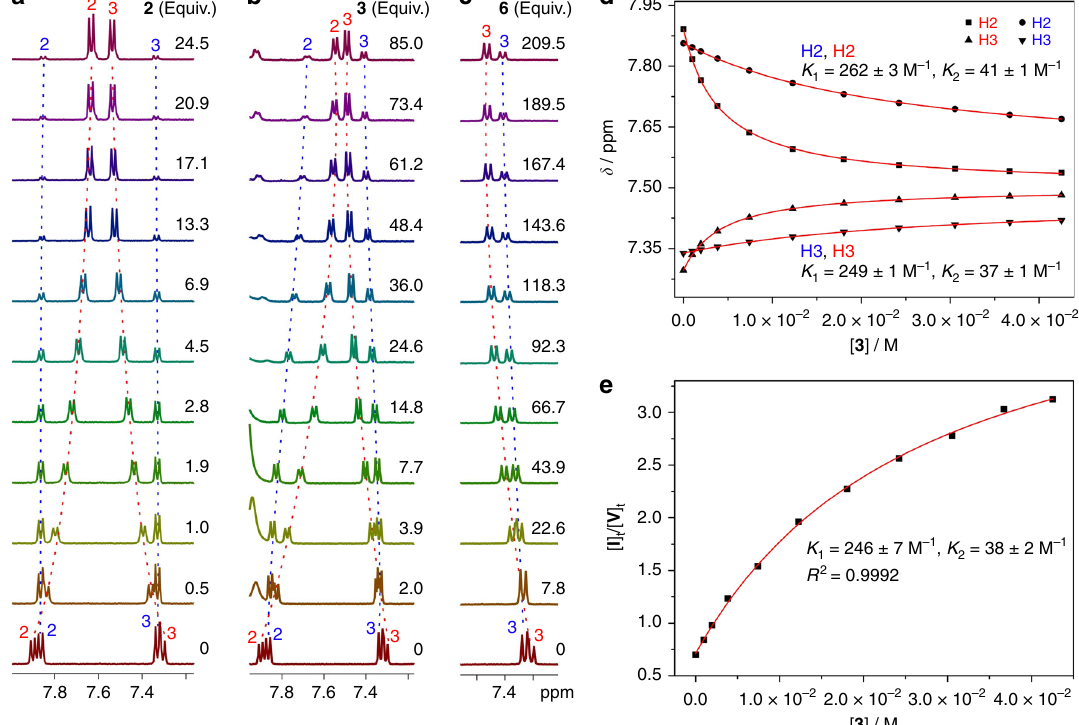
Fig. 6 NMR titration and nonlinear fi tting data. a – c Partial 1 H NMR spectra (500 MHz, 25 °C) of 1 (0.5 mM) during titration with guests 2 , 3 and 6 , respectively, in CD 2 Cl 2 . d , e Nonlinear curve- fi ttings of the 1 H NMR data of 1 titrated by 3 according to Eqs. (6) and (7) and according to Eq. (8),